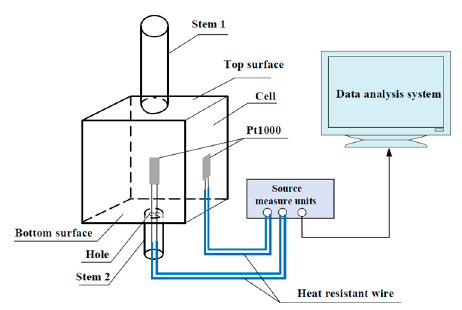
Figure 3. Schematic of the temperature-measuring device